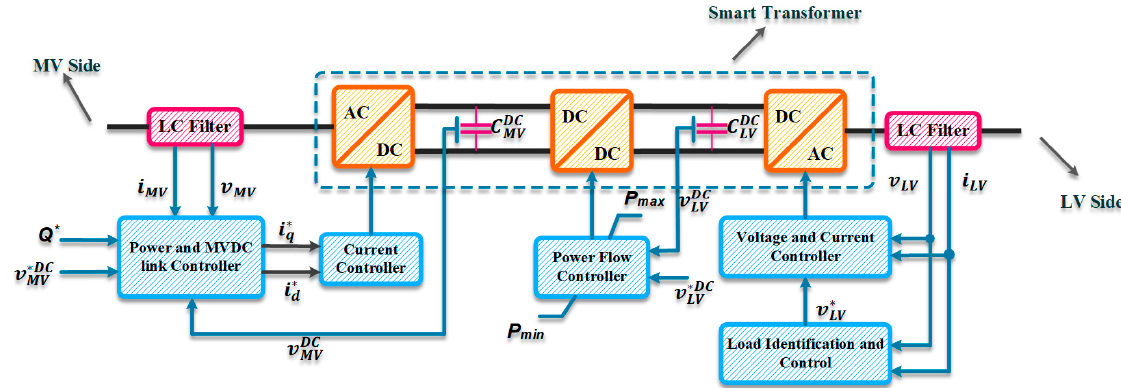
Figure 20. Load sensitivity identification system through ST utilization [133].